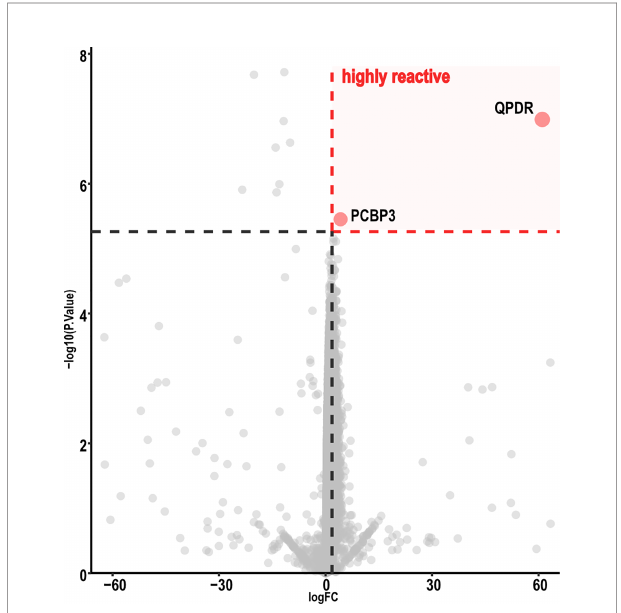
FIGURE 3 | Volcano map analysis of ChAdOx1 samples. Volcano plot representing FC versus P -values of each protein displayed only two proteins highly reactive with ChAdOx1 serum samples. Graphic representation focuses from − 60 to 60 in a log FC range. Thresholds were established by analysis of the FC ( ≥ 2.5) and adjusted P -value (< 0.01). ChAdOx1 was compared by R package Limma; Benjamini, as well as Hochberg procedure, was used to adjust P